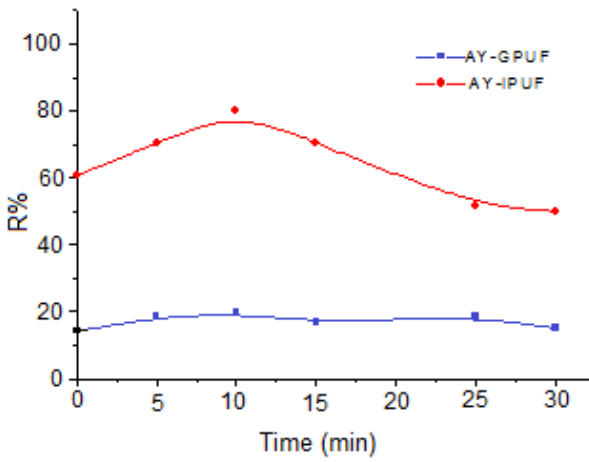
FIGURE 10 - The effect of shaking time on the sorption of CAF: 0.25 μg.mL -1 , 0.1 g sorbent, pH 5.5 AY-GPUF and pH